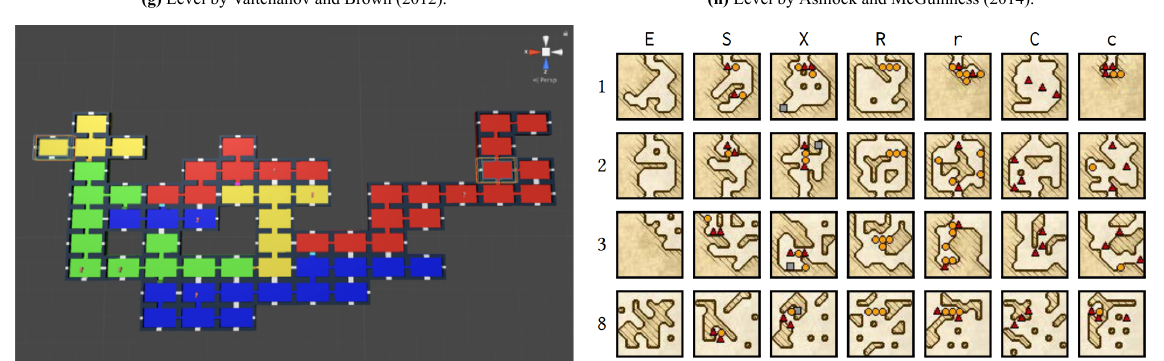
Figure 8. Some works that presented area or room distinction in their